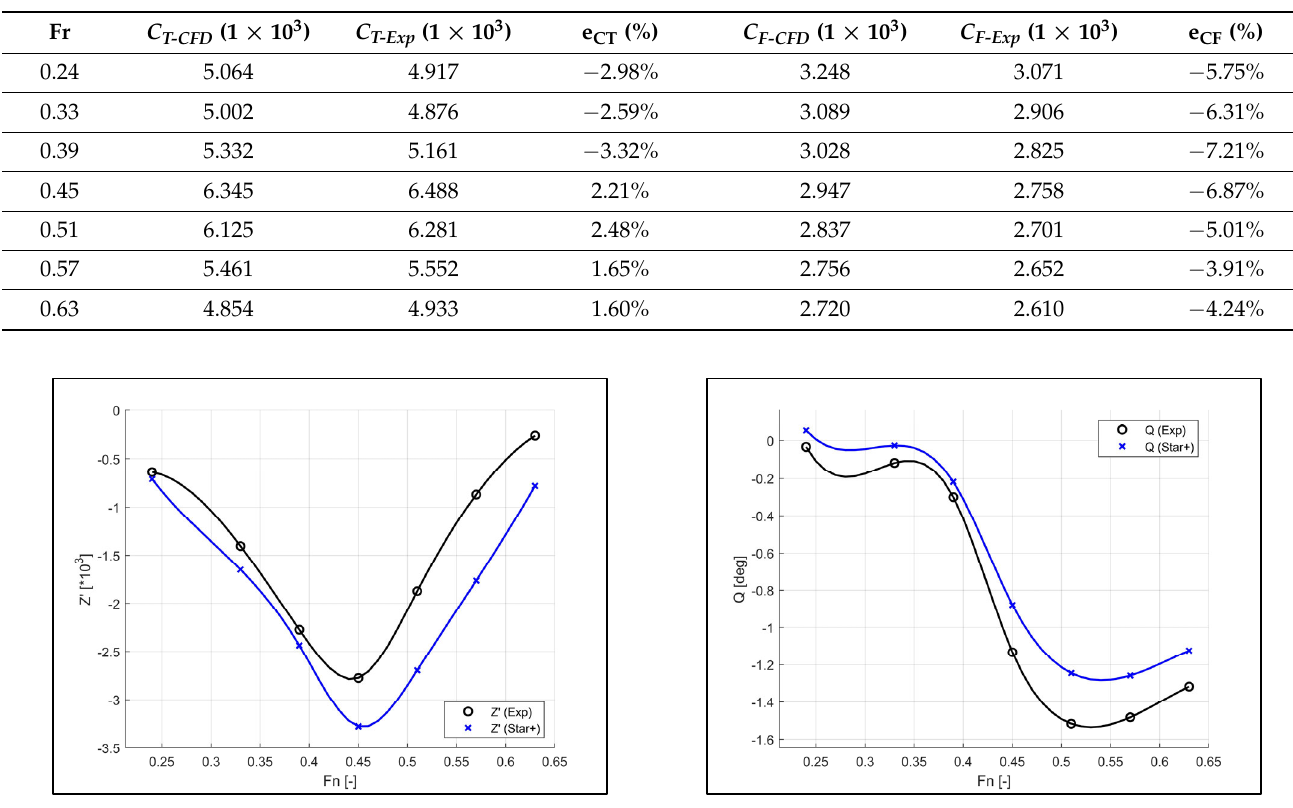
Figure 7. Numerical sinkage ( left ) and trim ( right ) values compared to the experiments. Table 5. Resistance comparison for LC1.